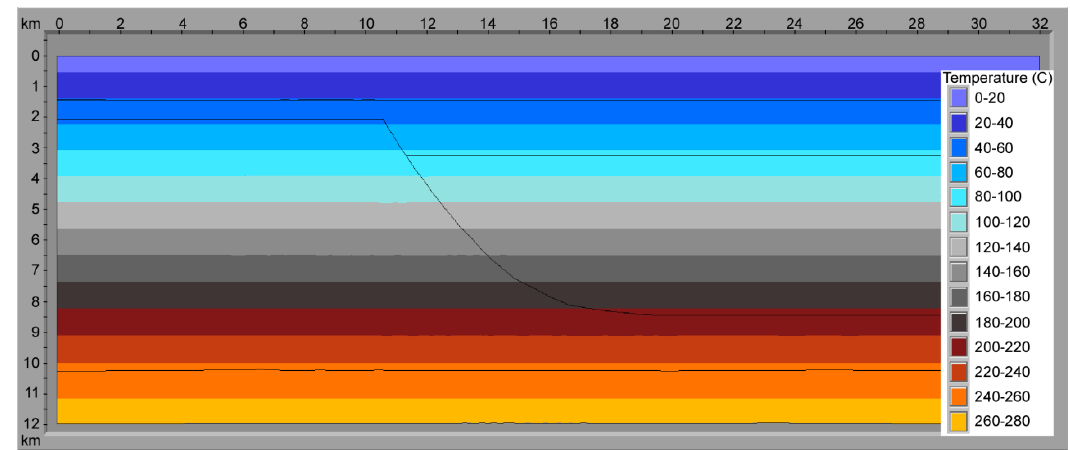
Figure 3. Temperature regime for the modeled basin in steady state solution.